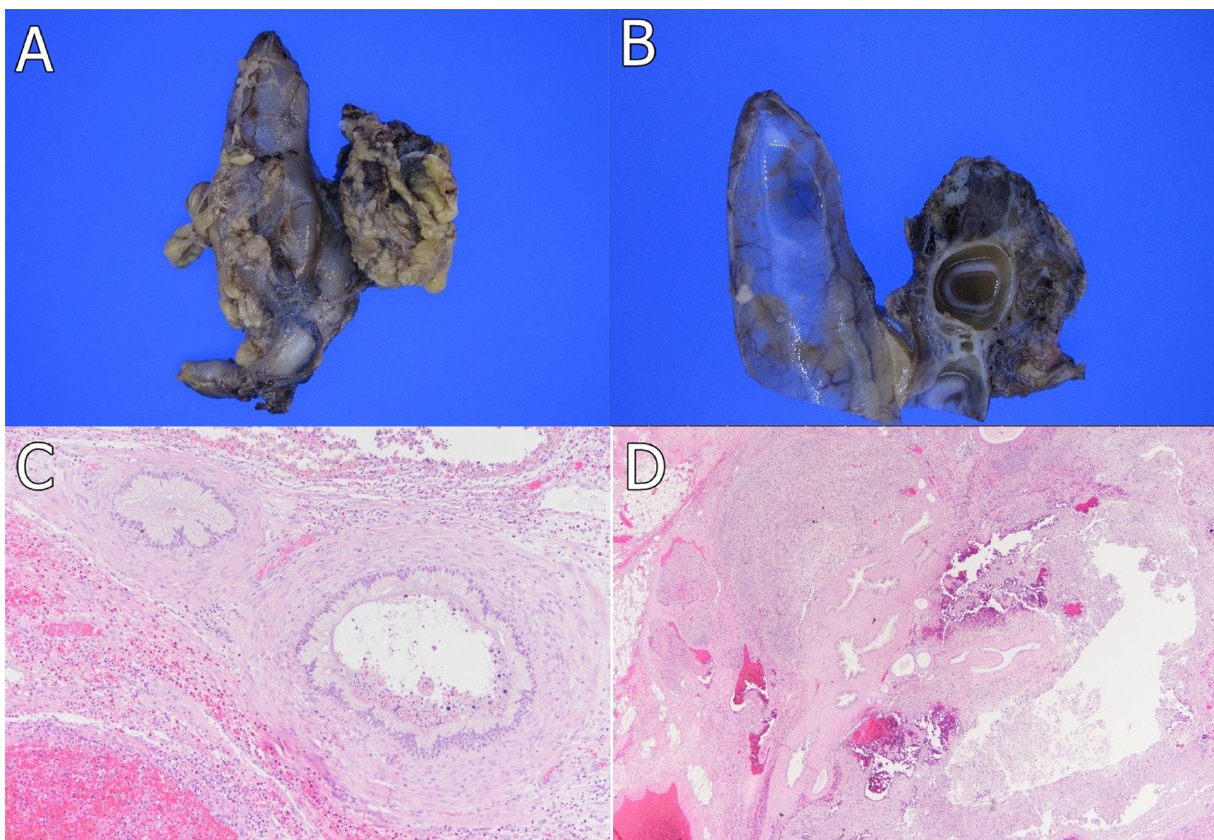
Fig. 4. Pathologic findings . (A,B) Convoluted tubular structures with cystic dilation were observed. (C) Low magnification showed cystic and glandular structures of various sizes. (D) High magnification showed pseudostratified columnar epithelium with semen, including sperm